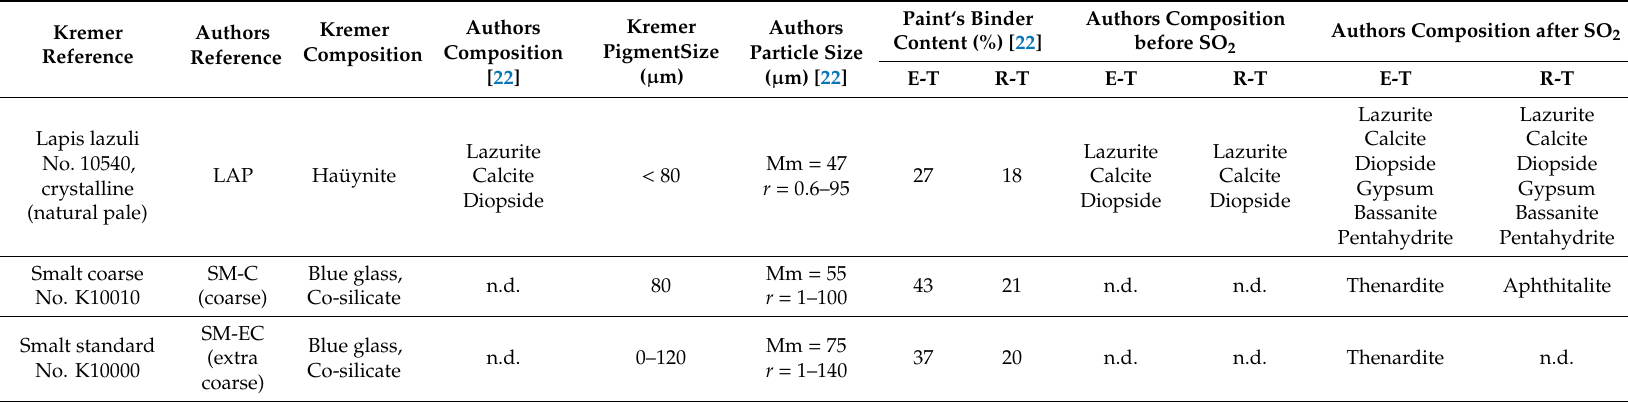
Table 1. Mineralogical / Chemical composition and grain size of the pigments according to Kremer supplier and to the authors [22], binder (egg yolk and rabbit glue) content in the tempera mock-ups, and mineral phases identified in the tempera mock-ups by XRD before and after SO 2 exposure. The author references are also shown. E-T: egg yolk-based temperas and R-T: rabbit glue-based temperas. Mm: maximum grain size and r : grain size